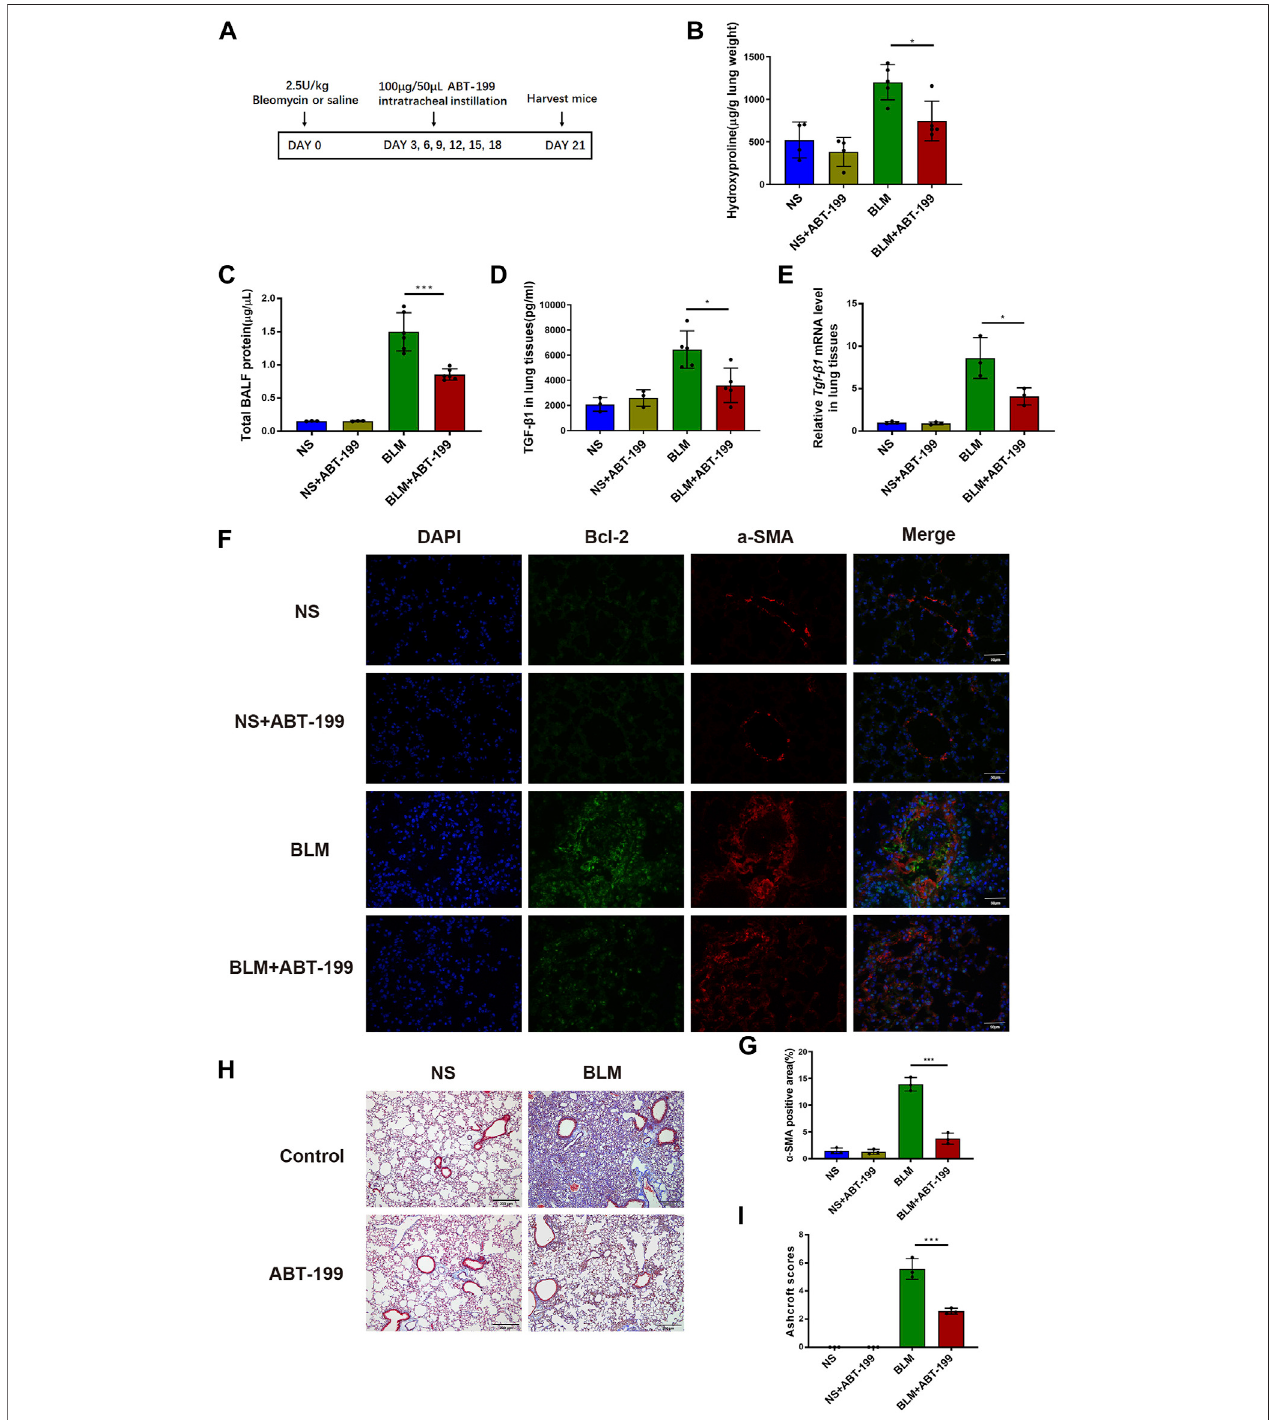
FIGURE 4 | ABT-199 alleviates BLM-induced lung fi brosis. (A) Treatment scheme. (B) Hydroxyproline contents in lung tissues. (C) Total BALF protein on day 21 wasmeasuredusingBCAProteinAssay. (D , E) ExpressionofTGF- β 1levelinthelungtissueweredeterminedusingELISAandreal-timePCR. (F) Representativeimages of myo fi broblasts in lung tissues by immuno fl uorescence staining of α -SMA and Bcl-2. (G) Quantitative analysis of α -SMA positive areas in lung sections. (H) Representative images of lung sections stained with Masson ’ s trichrome. (I) The area analysis of fi brotic changes according to Ashcroft scale. The data are presented as means ± SD of an experiment performed three times. * p < 0.05, *** p < 0.001. n (cid:2) 3 – 6. BLM, bleomycin; BAL, bronchial alveolar lavage; NS, normal saline; TGF- β 1, transforming growth factor- β 1; α -SMA, alpha smooth muscle actin.